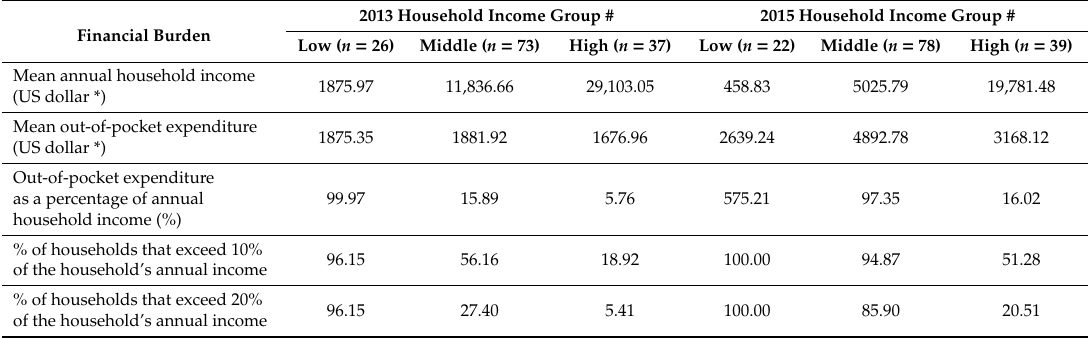
Table 6. Out-of-pocket payment for TB inpatient care in Zhenjiang, in 2013 and 2015, by household income